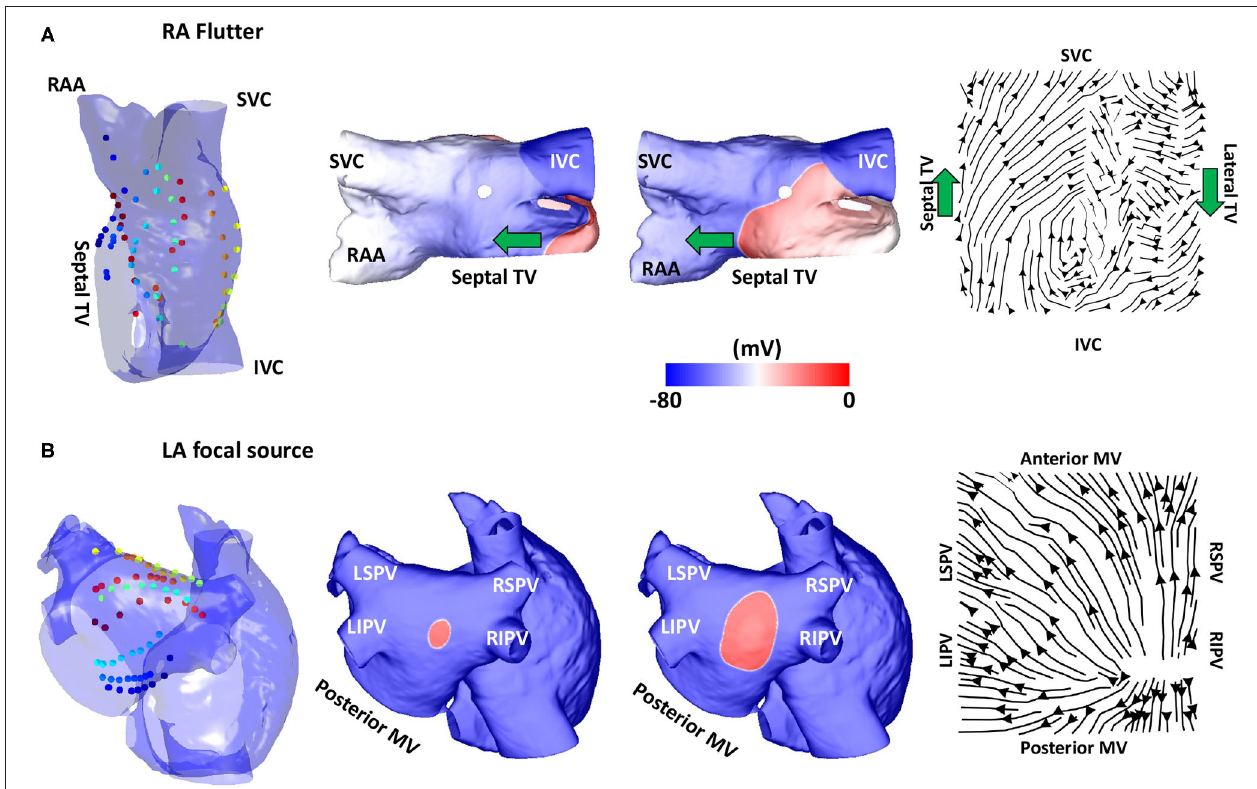
FIGURE 3 | Validation using simulated data: flutter and focal activity. (A) Simulated atrial flutter with activation streamlines from the IVC to SVC along the septal wall and from the SVC to IVC along the lateral wall, to complete the re-entry circuit. Basket location, isopotential plots and the activation streamlines are shown. The wavefront propagation path direction is indicated by the green arrows. The orientation of the RA in each sub-figure was chosen to offer easier visualisation of the electrode locations and the wavefront propagation direction. (B) A simulated repetitive focal source manifests as a divergent activation streamline field. TV, tricuspid valve; SVC, superior vena cava; IVC, inferior vena cava; RAA, right atrial appendage; MV, mitral valve; LSPV, left superior pulmonary vein; LIPV, left inferior pulmonary vein; RIPV, right inferior pulmonary vein; RSPV, right superior pulmonary vein; LA, left atrium; RA, right atrium.